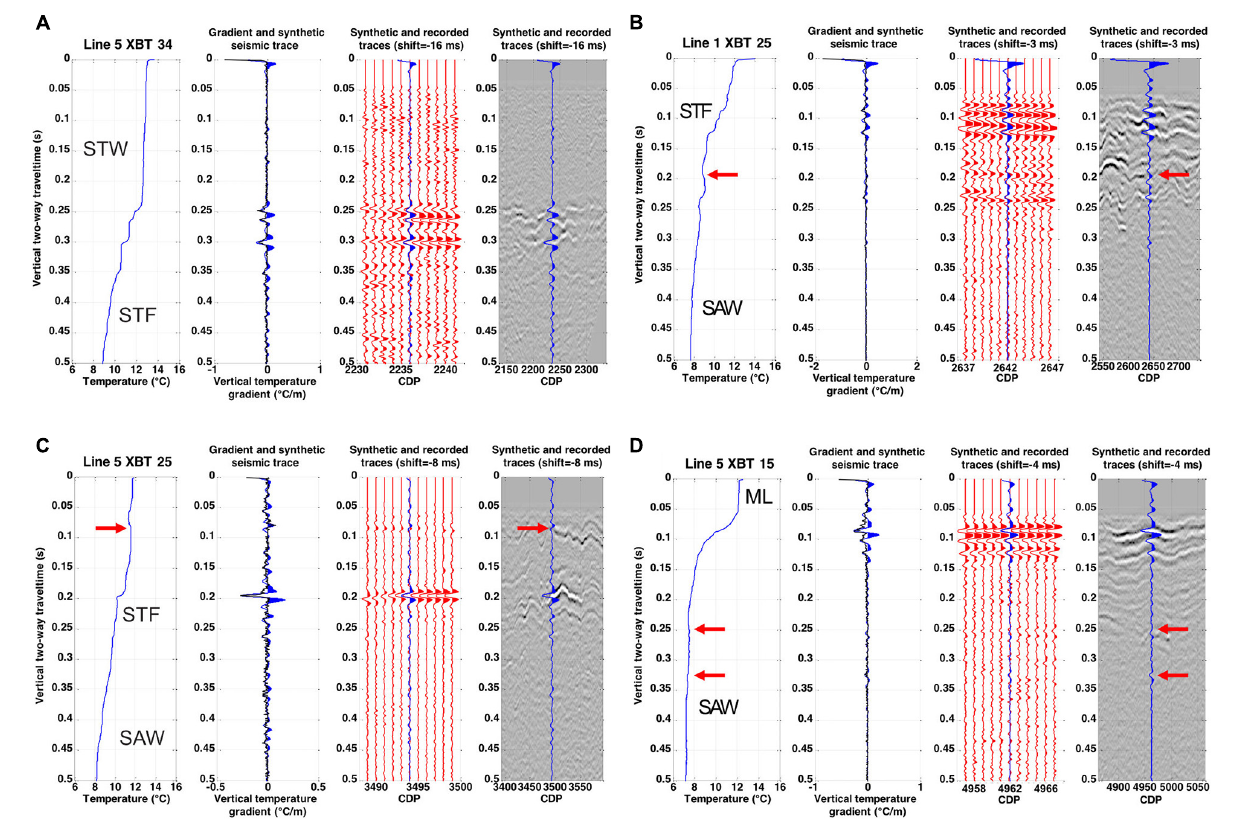
FIGURE 7 | Synthetic seismic ties for XBTs showing STW (A) , the STF (A–C) , SAW (B–D) , and the mixed layer (ML) (D) . Each of (A–D) consists of four panels, from left to right: temperature as a function of seismic travel time, vertical temperature gradient (black) and the synthetic seismic trace (blue), the synthetic seismic trace (blue) overlain on 11 adjacent traces from the recorded seismic data (red wiggle traces), and the synthetic seismic trace (blue) overlain on 201 adjacent traces from the recorded seismic data (greyscale image). Red arrows in (B,C) indicate temperature inversions associated with positive-polarity reflections. Arrows in d indicate weak reflections within